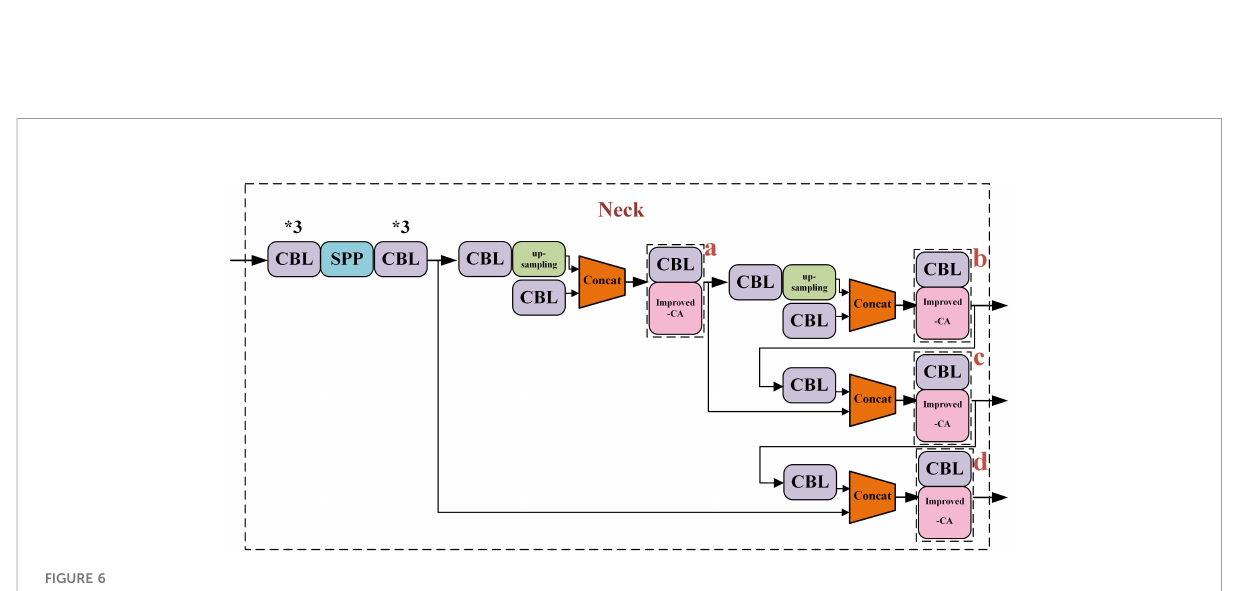
FIGURE 6 Improved combinational convolution-CA module at fusion.